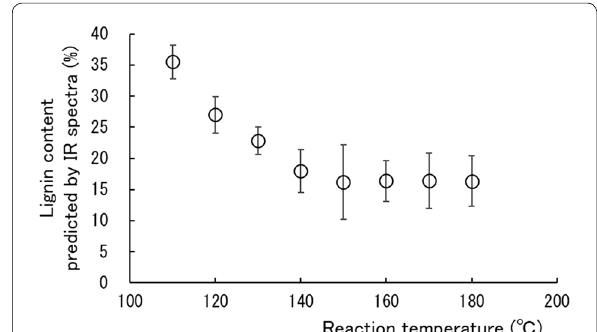
Fig. 3 Lignin content monitored by IR spectroscopy with increasing temperature during alcoholysis. The plots correspond to Samples 11–18 in Table 1. The error bars indicate the standard deviation calculated from 3 samples